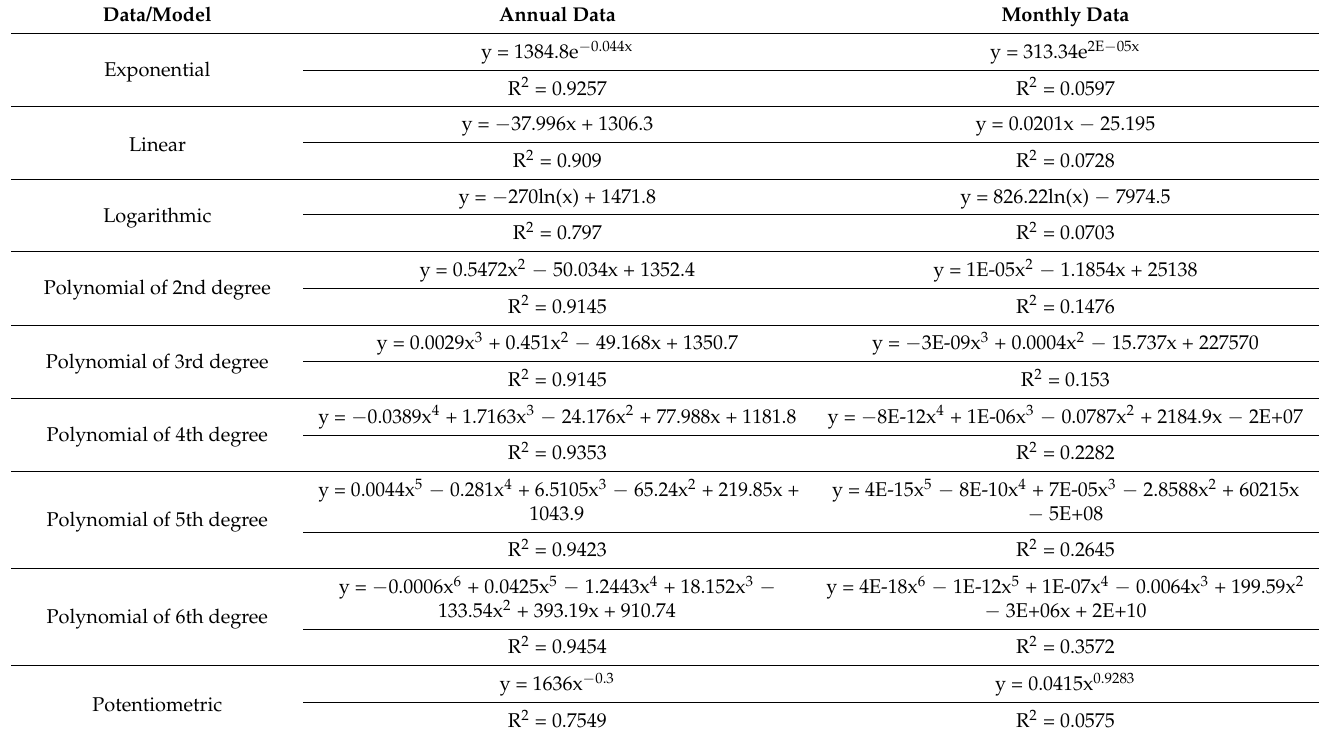
Table A8. Trend models for Opole province.